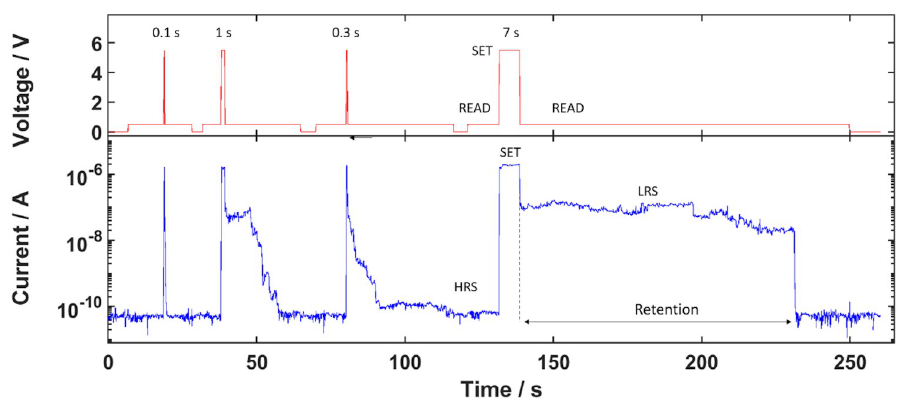
Fig 6. Time-resolved current measurements showcasing the retention. The upper graph shows the applied voltage pattern: Read voltage = 0.5 V, Set voltage = 5.5 V. The retention time is taken as the time from returning from Set to Read voltage to when the current reaches the HRS current. The numeric values indicate the duration of the Set voltage pulse. The Set time and retention time show a positive correlation, which can be found in the (see S4 Fig).